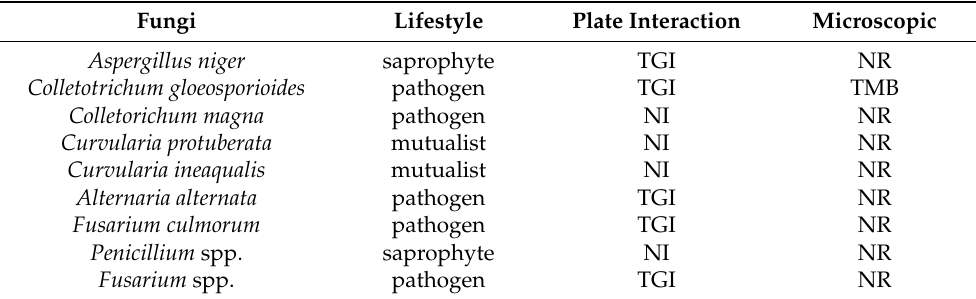
Table 4. Dual plate Interaction of ThSM3a and other fungi.